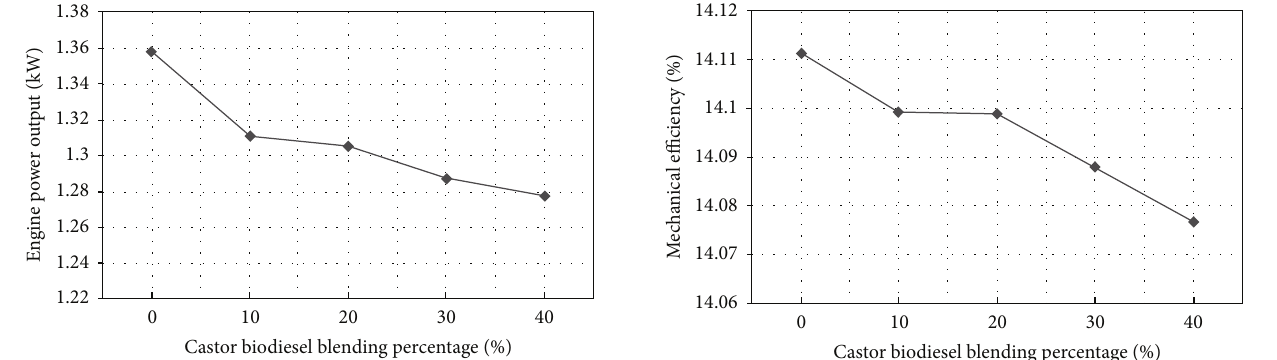
Figure 7: Mechanical efficiency versus castor biodiesel blending percentage.